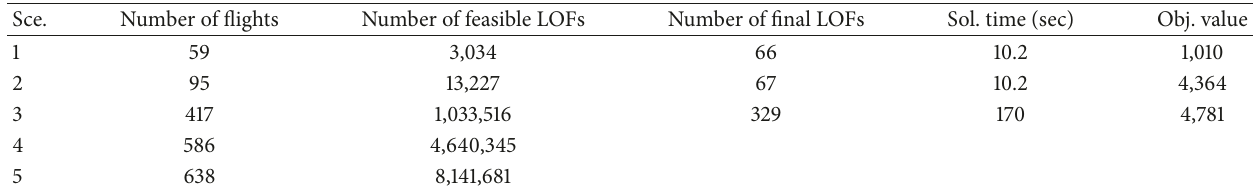
Table 2: Computational results of the ARM for the five test scenarios.